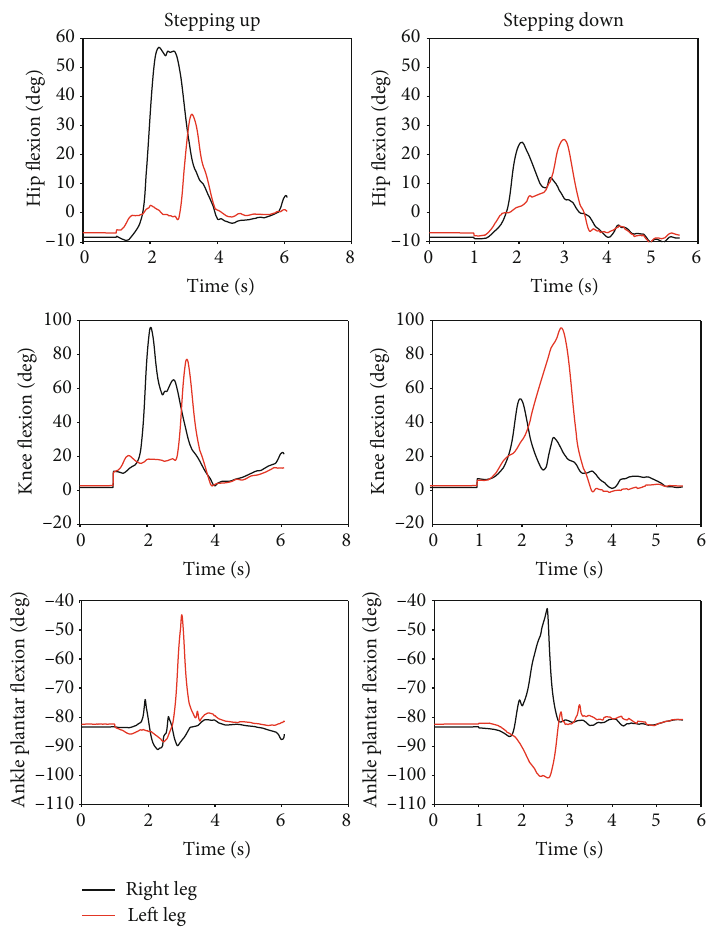
Figure 12: Joint angles during stepping up (left fi gures, trial 4) and stepping down (right fi gures, trial 5). The right leg is the leading leg and the left leg is the trailing leg for both trials. These results are from subject